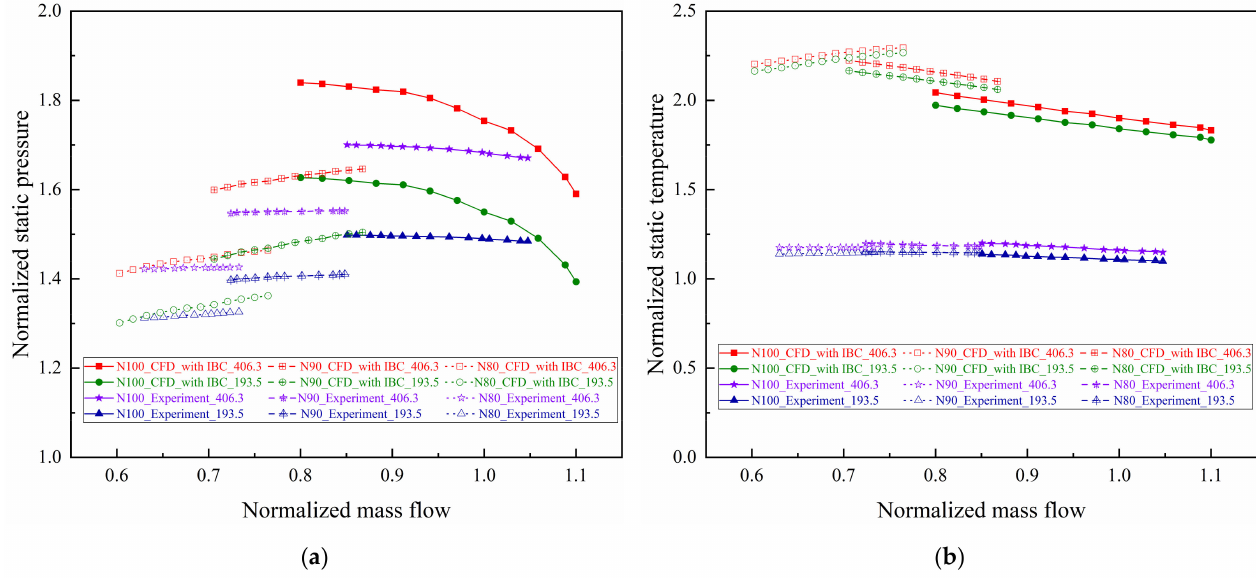
Figure 13. Predicted and measured static pressure and static temperature on the static wall of IBC under variable rotating speeds: ( a ) static pressure; ( b ) static